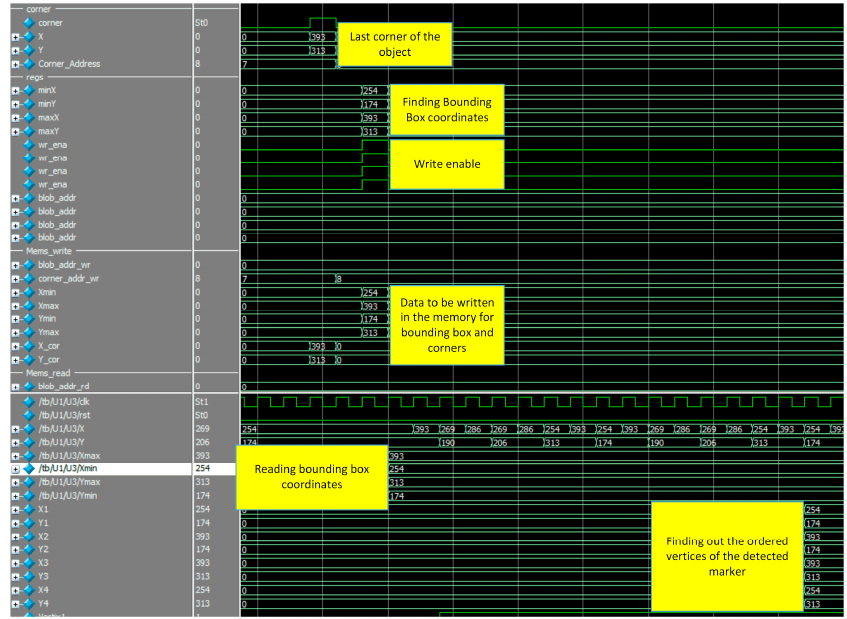
Figure 16. Whole system simulation results.